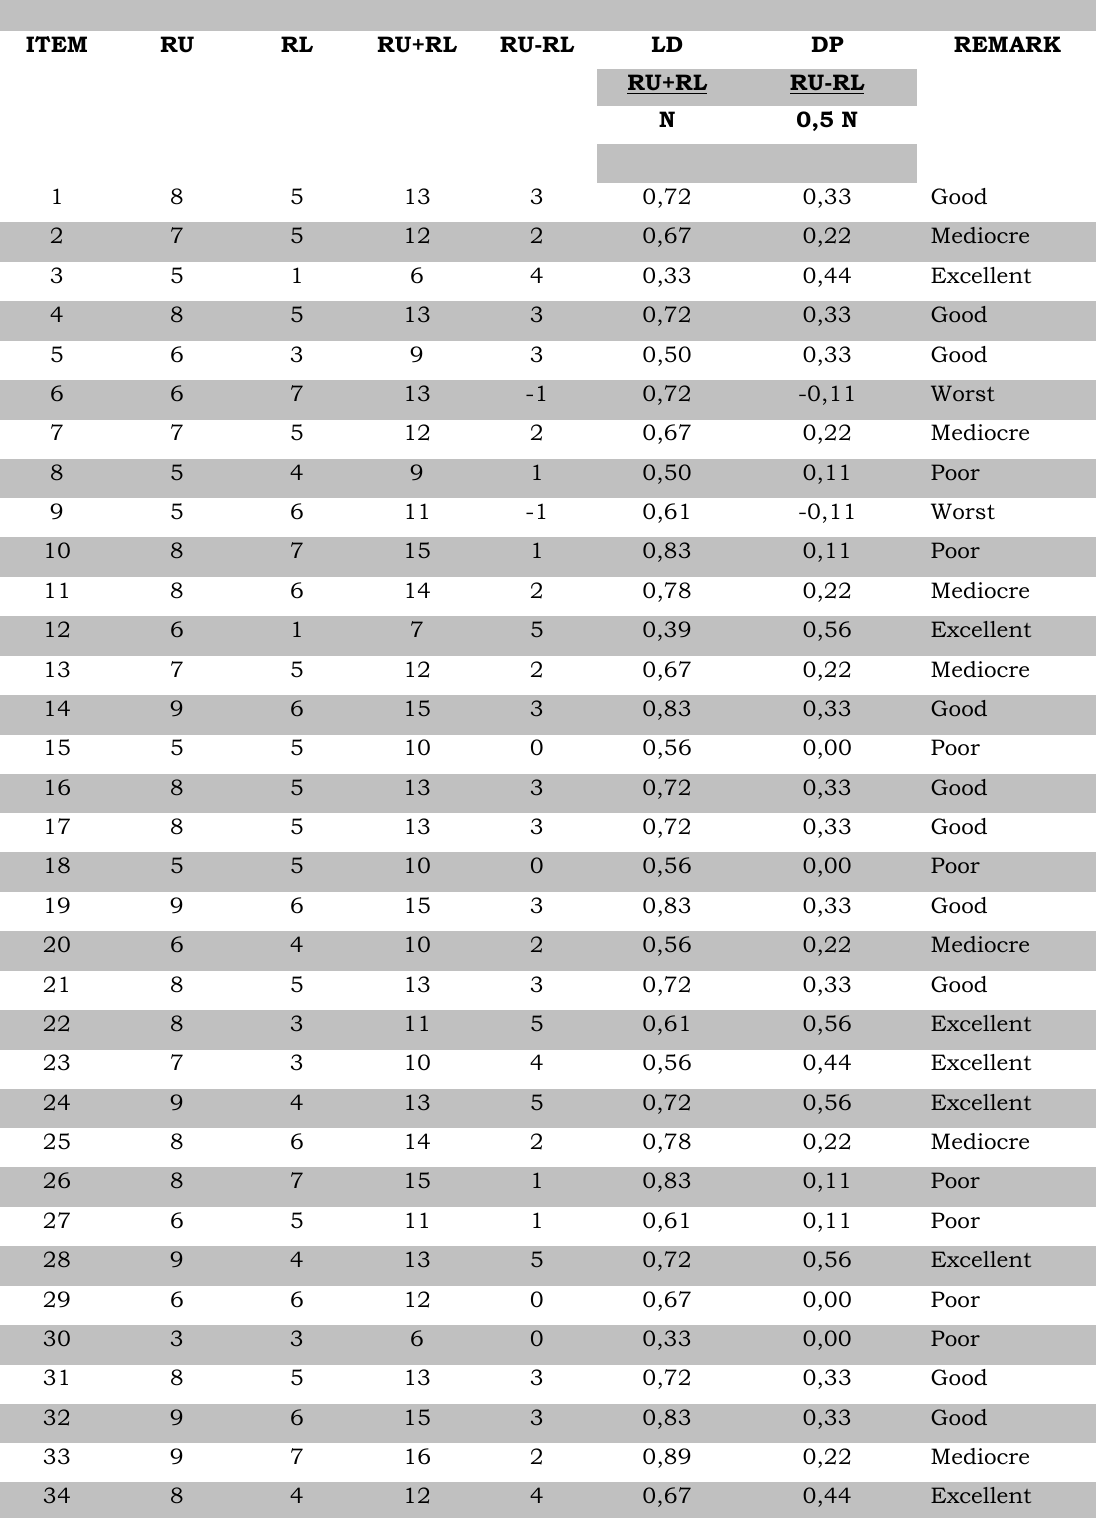
Table 3. Level of Difficulty (LD) and Discriminating Power